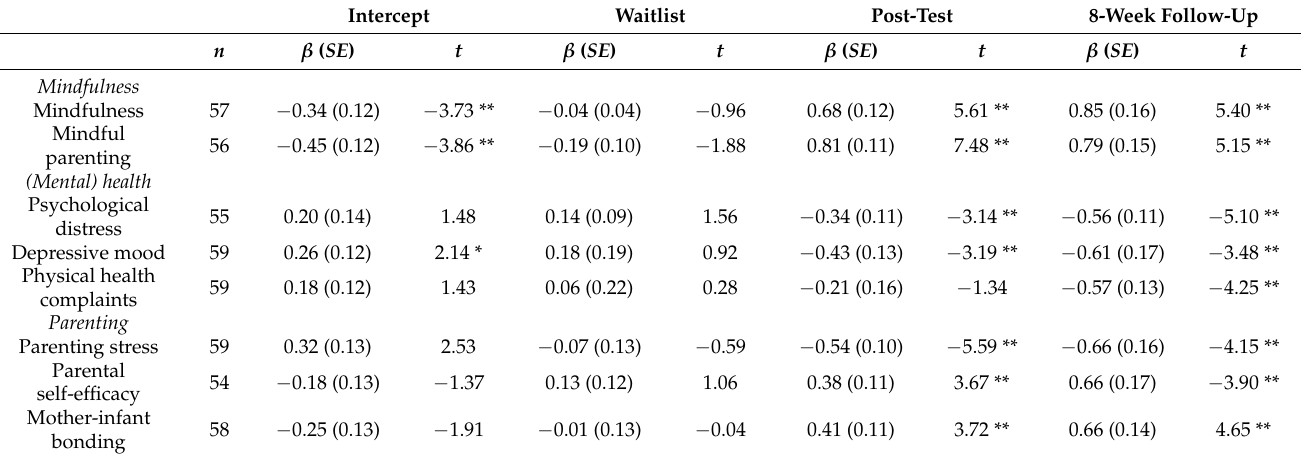
Table 4. Parameter estimates (standard error between brackets) followed by t values of